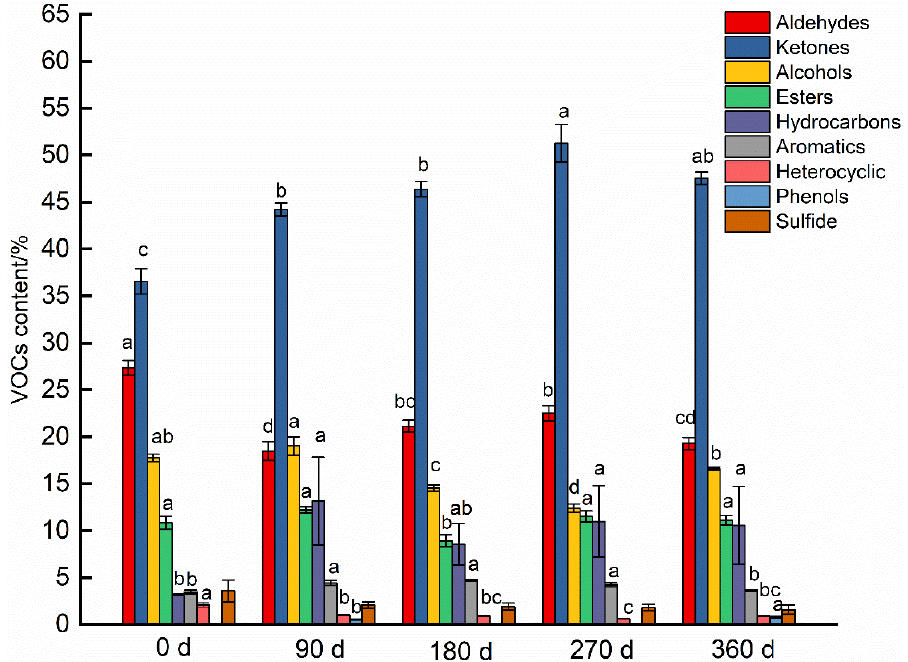
Figure 5. Changes of VOCs in alfalfa at different storage durations. Different lowercase letters indi-